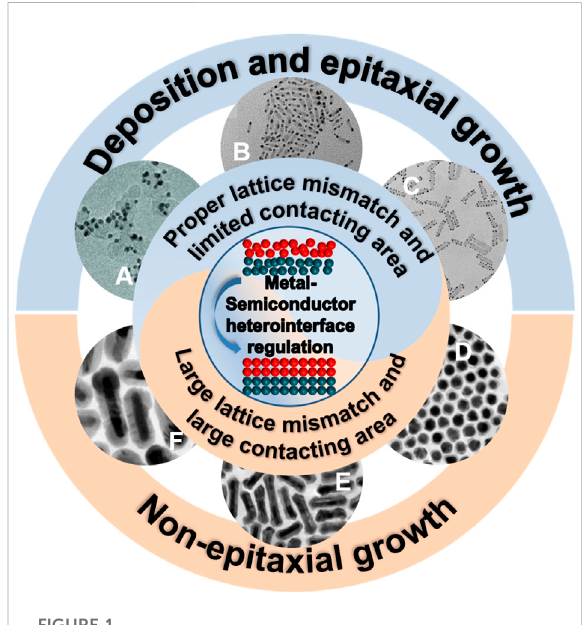
FIGURE 1 Schematic diagram of synthetic methods for interface regulation of different materials. (A) Adapted from Hunt et al. (2016). (B,C) Adapted from Naskar et al. (2015). (D) Adapted from Liu et al. (2018a). (E) Adapted from Li et al. (2019). (F) Adapted from Wan et al.